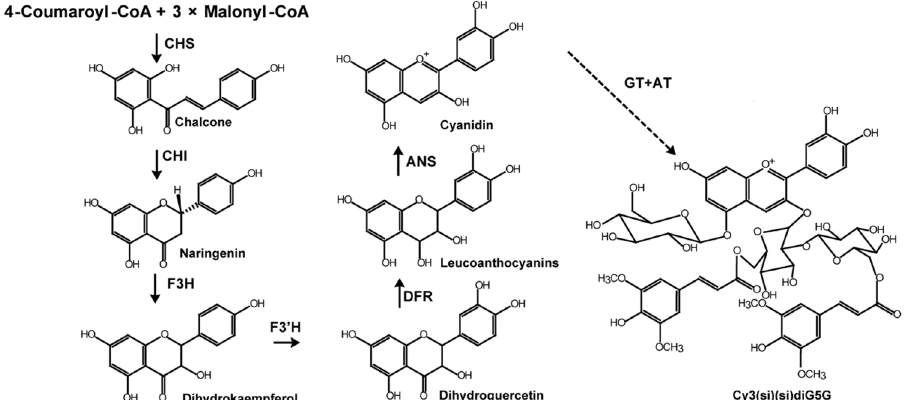
Figure 4. The biosynthetic pathway of the anthocyanins. Scheme displaying the biosynthetic pathway of Cy-3- O -(sinapoyl)(sinapoyl)-diglucoside-5- O -glucosidein red cabbage. The biosynthetic pathway of anthocyanidins leads to the biosynthesis of cyanidin, which is further modified with several glycosyl and acyl moieties added in a species specific manner by glycosyltransferases and acyltransferases (indicated by dotted